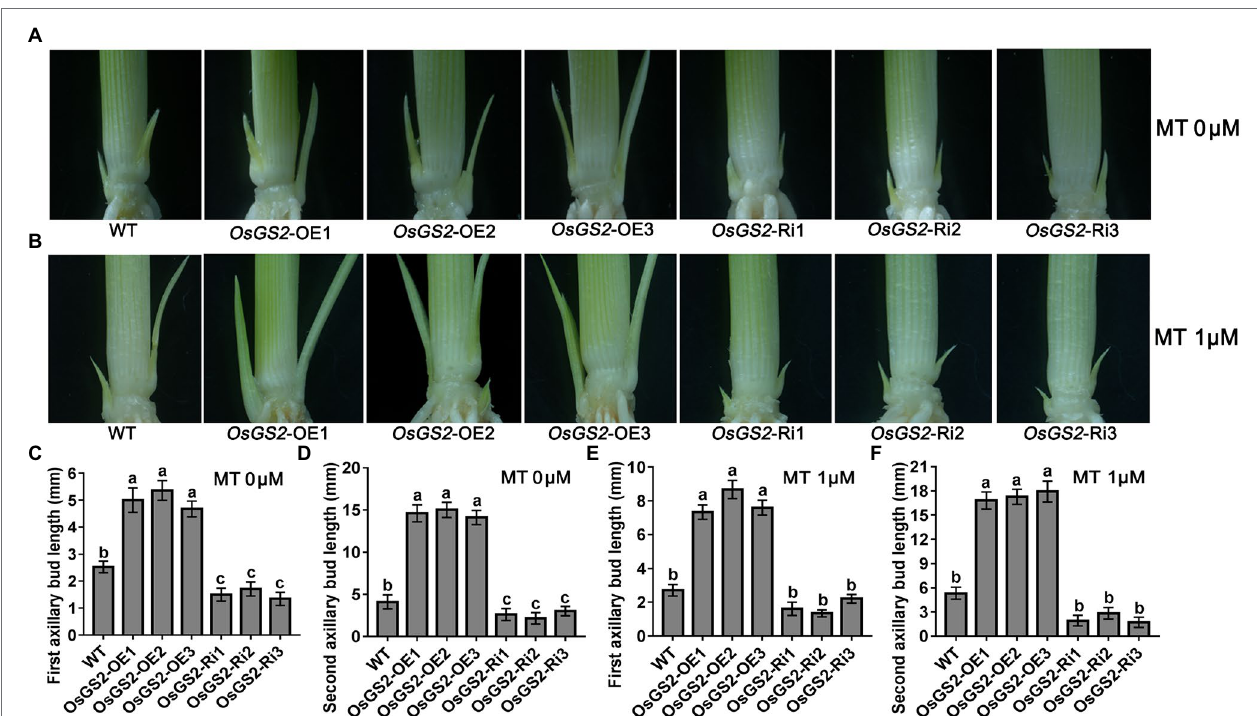
FIGURE 8 | Effect of melatonin on outgrowth axillary bud of OsGS2 transgenic seedlings. Phenotypes of outgrowth axillary bud with altered expression of OsGS2 grown under 0 μ m melatonin (A) and 1 μ m melatonin (B) . Statistical analysis of the first (C,E) and second (D,F) axillary bud length in (A,B) . Values are means ± SD ( n > 20), and the significance levels of different lowercase letters were as follows, p < 0.05. WT represents wild-type ZH11, OE1-OE3 represent three lines of OsGS2 over-expressing transgenic plants, and Ri1-Ri3 represent three lines of OsGS2 RNAi transgenic plants. MT represents